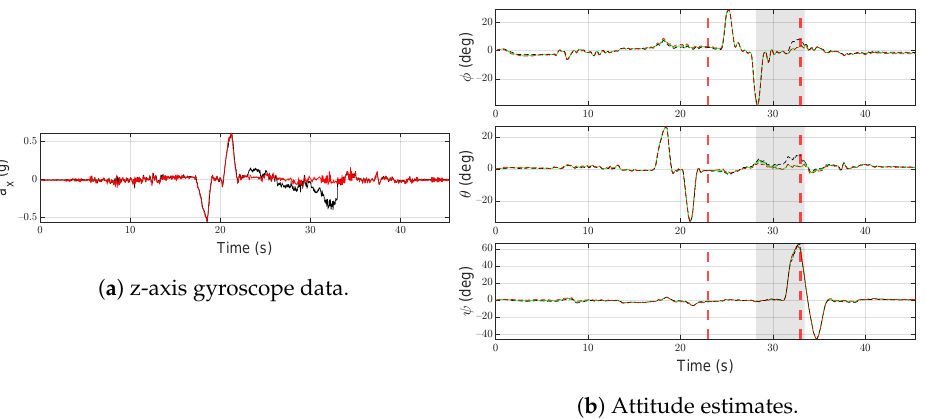
Figure 11. Scenario F5. Black lines denote measurements/estimates from IMU-1, red lines are for measurements/estimates from IMU-2. Green lines represent the output of the system, gray areas highlight the time interval in which the SFDI algorithm is in the fault state. Vertical red dashed lines denote the time instants when the fault occurs and